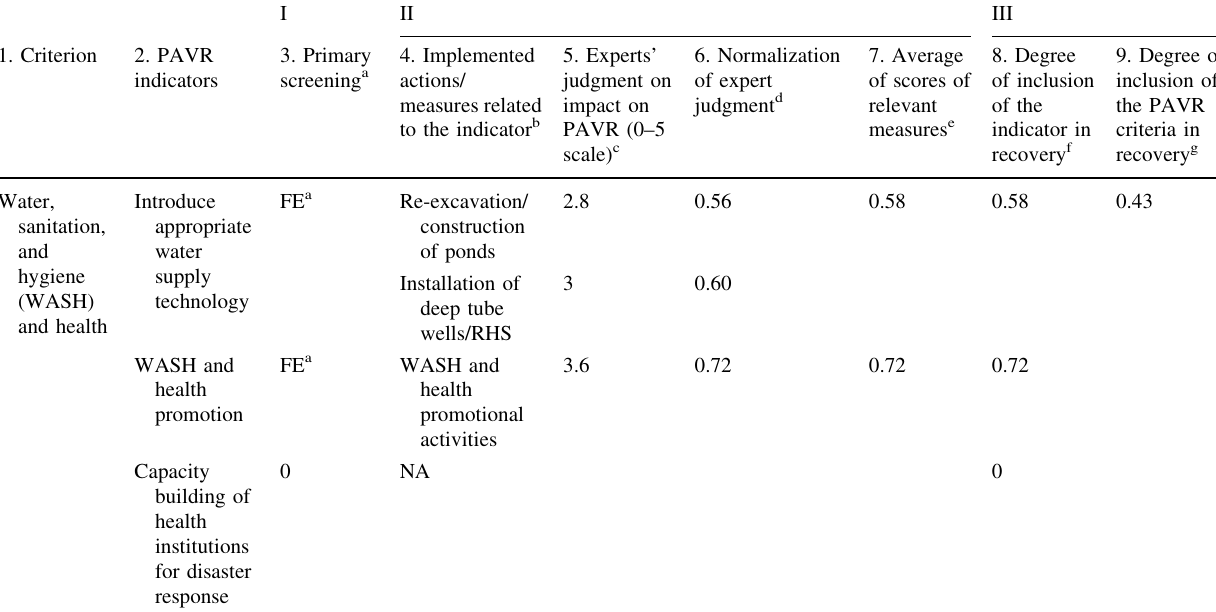
Table 1 A sample table showing details of scoring and calculating inclusivity of PAVR